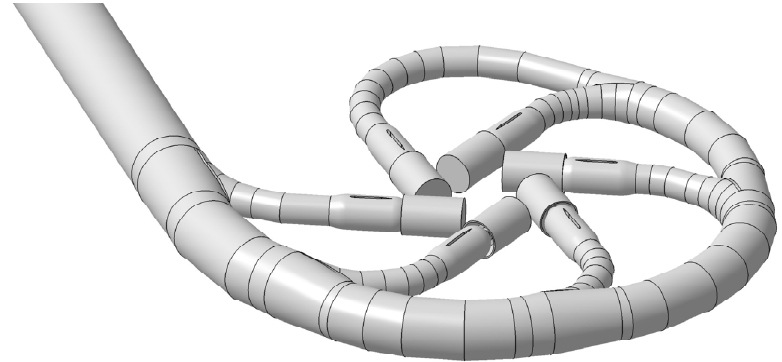
Figure 2. The geometry of the distributor simulation domain.